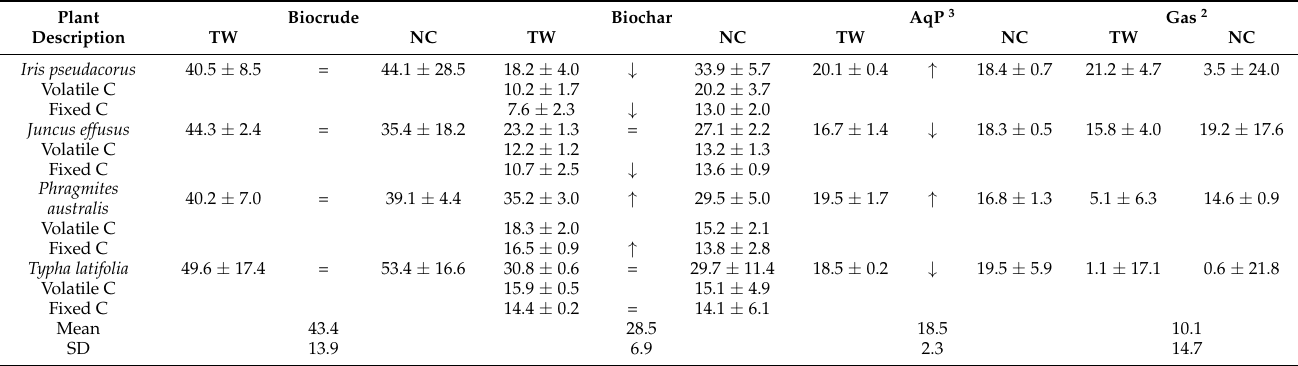
Table 8. Carbon balance 1 for the different HTL fractions obtained from the selected plants and the different growing